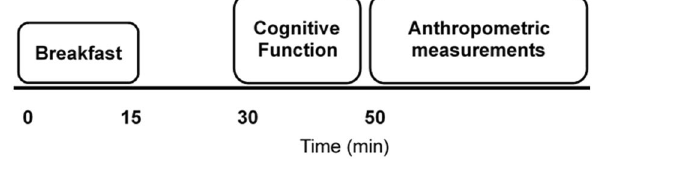
Figure 1. Overview of study design.